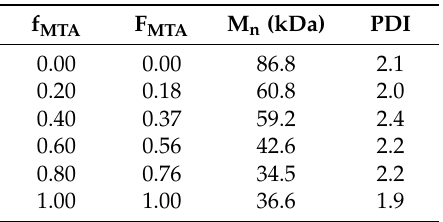
Table 1. Characterization of the P(MTA- co -HEMA) copolymers.